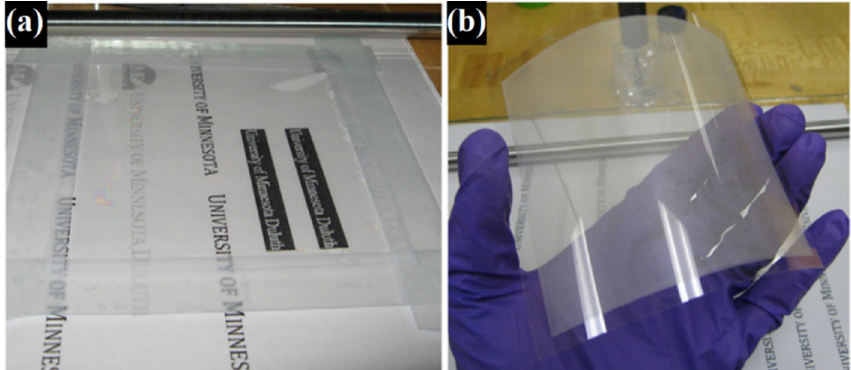
Figure 8. ( a ) Fabricating the Ag NW thin film via rod‐coating method; and ( b ) a large, uniform, and flexible Ag NW thin film deposited on PET substrate. Reproduced with permission from [19]. Copyright 2011 Springer Publishing.